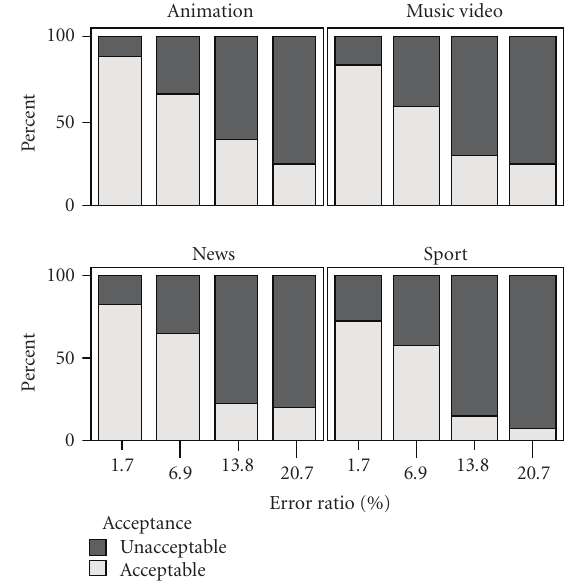
Figure 4: Acceptance of di ff erent error rates for all contents.